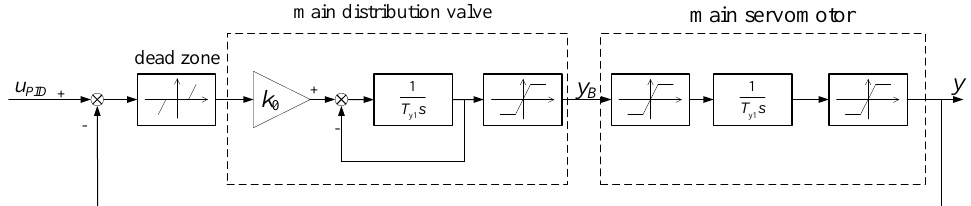
y ref + - Kp Figure 7. Structure diagram of the PI D   . The transfer function of the PI D   controller is shown as Equation (13). ( ) ( )